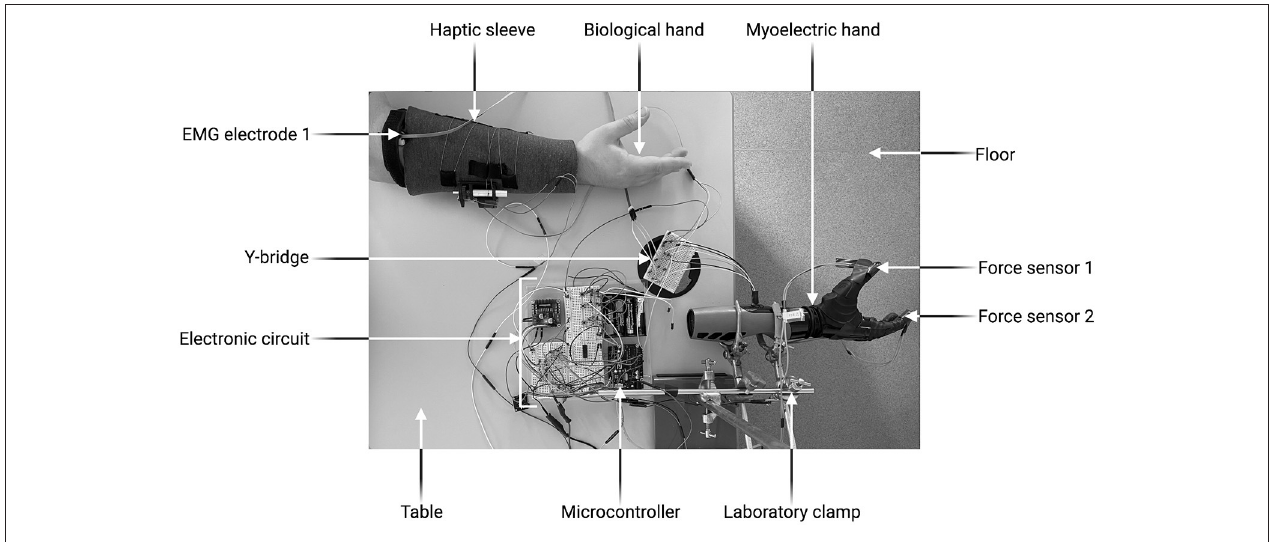
FIGURE 4 | Experimental set-up. Created with